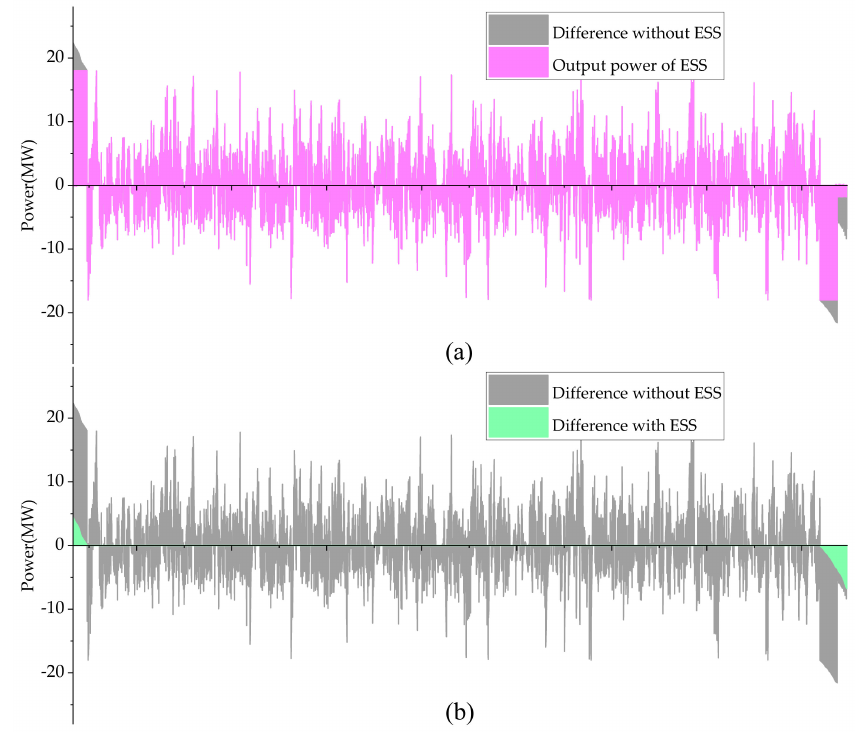
Figure 12. Data perspective of the output di ff erence: ( a ) di ff erence of power without ESS and output power of ESS and ( b ) di ff erence of power without ESS and di ff erence of power with